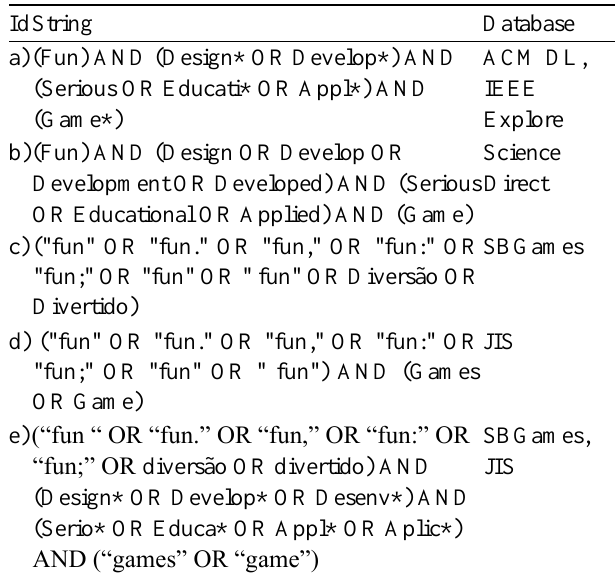
Table 2. Search strategies